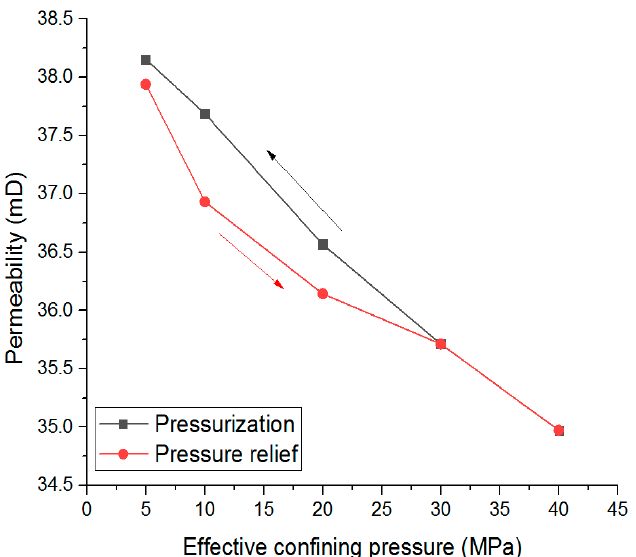
Figure 3. Variation in permeability of medium porosity and permeability sandstone with net confining pressure.